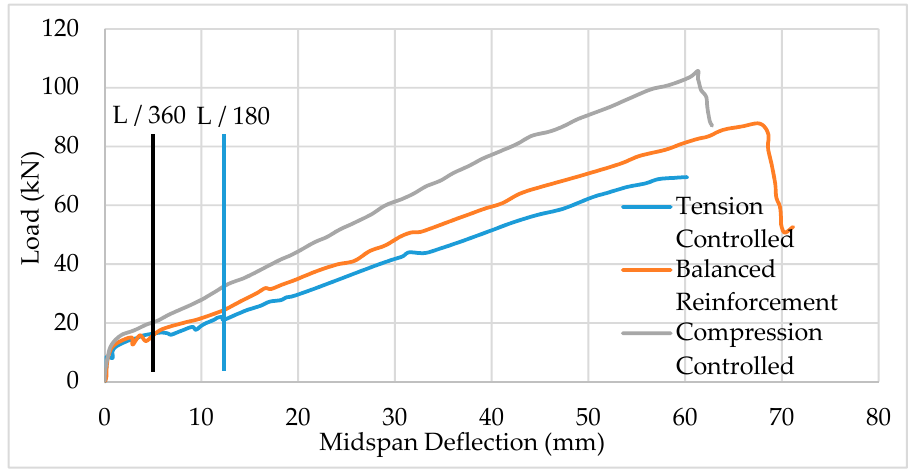
Figure 6. Load–deflection relationship for beams reinforced with BFRP bars and BFRP stirrups Reprinted with permission from ref. [16]. Copyright 2021 American Society of Civil Engineers.